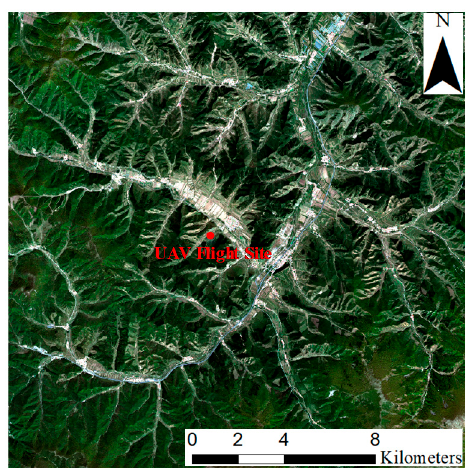
Figure 2. Sub-area of processed Sentinel-2A multispectral image including UAV flight site (located at the red